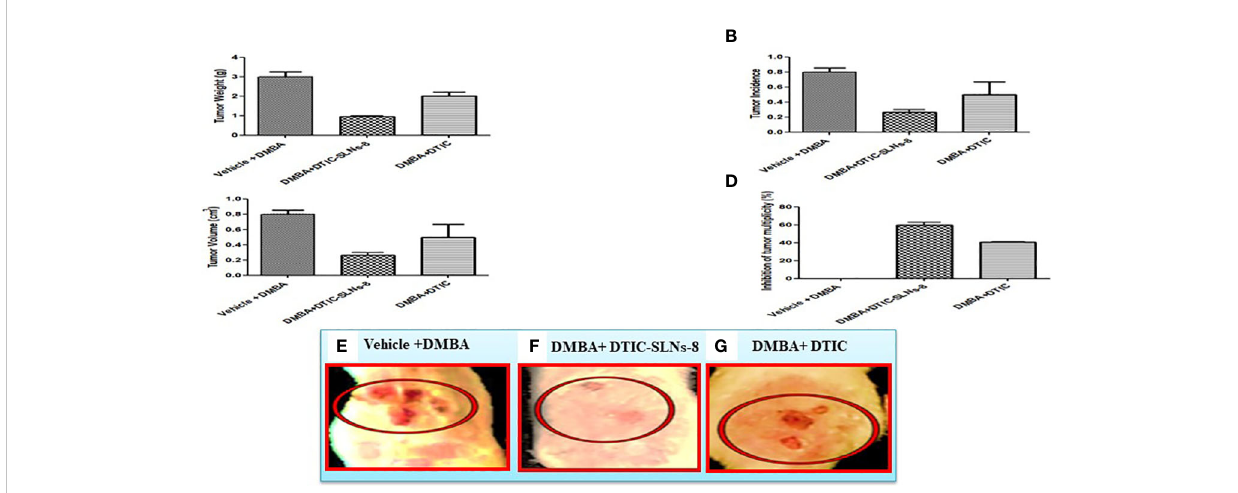
FIGURE 7 DTIC-SLNs-8 inhibits tDMBA-induced skin tumor occurrence, multiplicity, volume and weight. Representative bar graph are shown the effect of DTIC-SLNs-8 on DMBA-induced skin tumorigenesis; (A) the change of tumor weight of rats in every two weeks until the end of experiment period i.e. 18 weeks, (B) percentage of tumor incidence of rats thoughout the duration of experiment, (C) percent inhibition of tumor multiplicity with respect to DMBA alone treated group, (D) average tumor volume of all experimental groups, (E) Vehicle with DMBA tumor image (F) DMBA +DTIC- SLNs-8 tumor image (G) DMBA + DTIC tumor image. Control, acetone (vehicle) treated group; DMBA, DMBA/TPA treated group; DMBA+DTIC- SLNs-8, DMBA/TPA-treated rats with DTIC-SLNs-8 with Gellan gum (0.01%w/v); DMBA+DTIC, DMBA/TPA-treated rats with DTIC with Gellan gum (0.01%w/v). Each data point is represented as mean ± SD of 10 rats in each group. Statistical analyses were performed with Student ’ s t-test. *p < 0.01 compared with DMBA alone treated group. **P ≤ 0.01. represent signi fi cant different than disease control group.